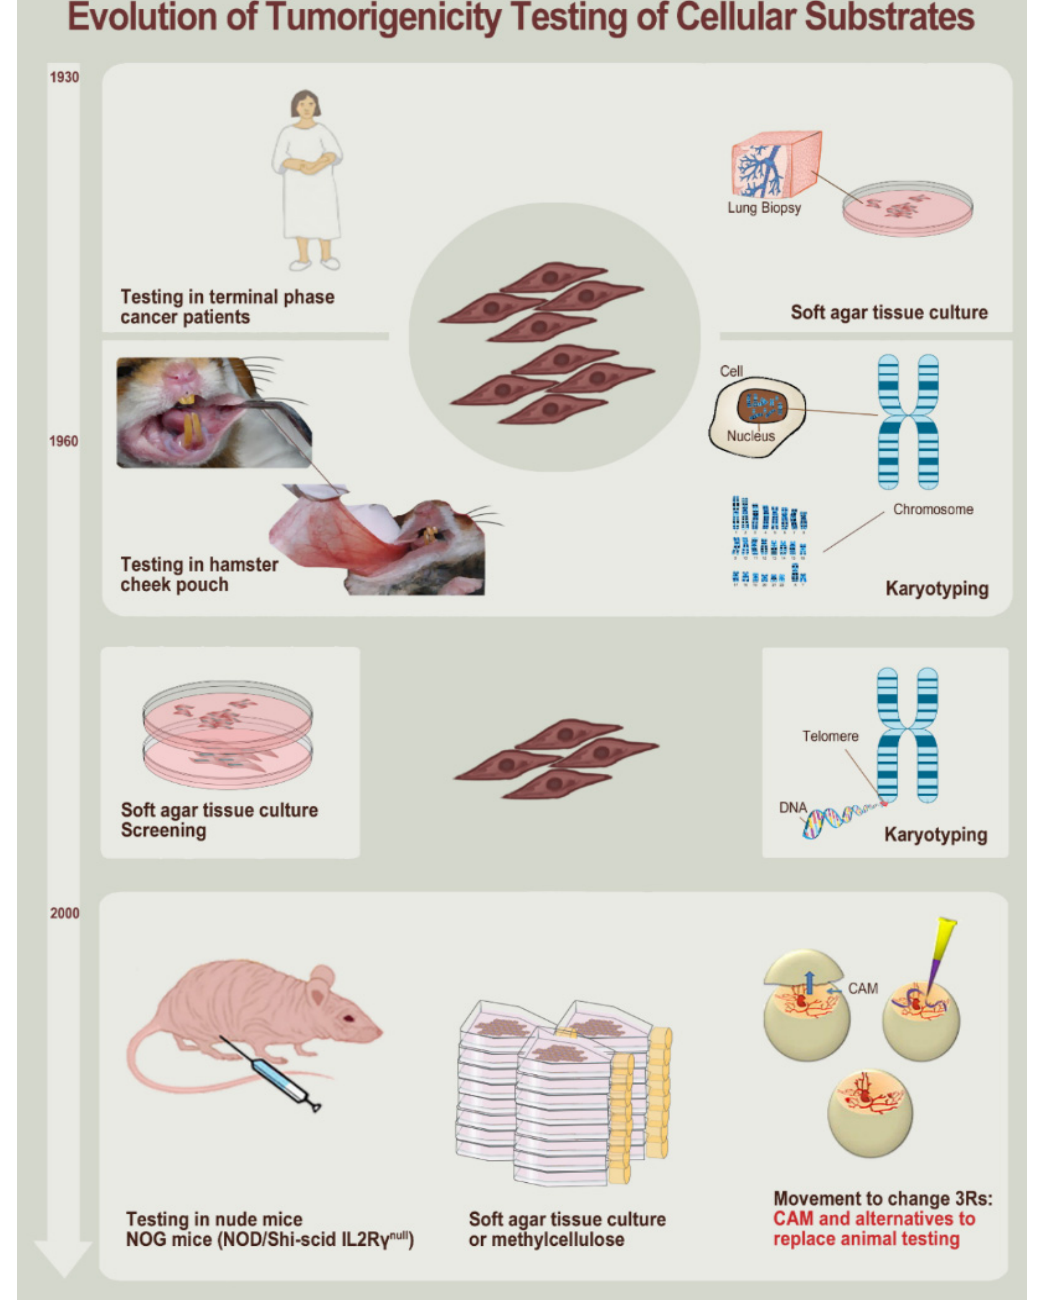
Figure 2. Evolution of tumorigenicity testing methodologies for cellular substrates. Testing was changed from ethically questionable use of terminal cancer patients to animal models (e.g., hamsters and mice), with the apparition of a more recent movement to avoid animal inclusion in testing processes. High throughput testing has always included soft agar cell colonization assays for preliminary screening, along with tumorigenicity testing in mice. More sensitive and alternative methods for some cell types have been implemented (e.g., in vitro use of methylcellulose), and novel mice strains have been specifically developed (e.g., NOG mice), with the designed ability to enhance the sensitivity for detection of tumorigenic potential. A current movement exists to validate alternative models to animal testing, such as the CAM model (i.e., chicken chorioallantoic membrane model), and to phase out animal experimentation for tumorigenicity testing (i.e., 3R rule for responsible animal testing: “Replace, Reduce, Refine”) [75]. CAM, chorioallantoic membrane; DNA, deoxyribonucleic